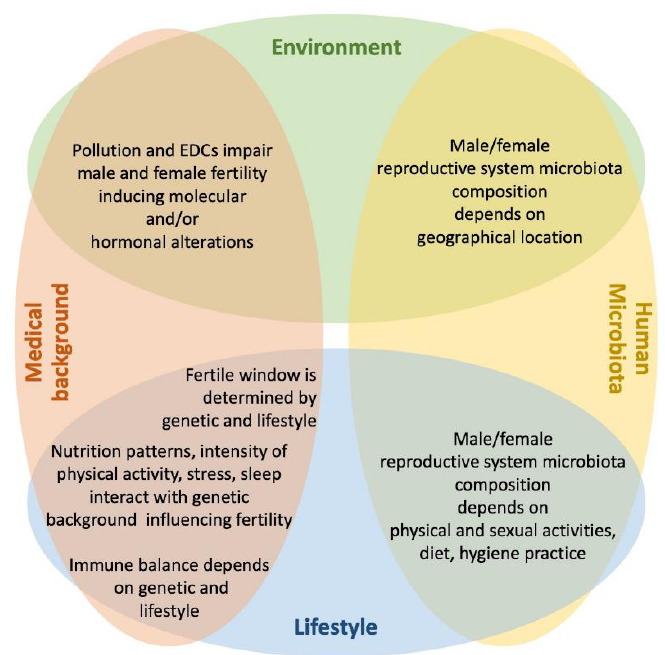
Figure 5. Intrinsic (microbiota and medical background) and extrinsic (lifestyle and environment) factors can have an impact on the overall state of reproductive health. It is interesting to note how what we can choose (i.e., physical activity, diet, habits) intrinsically affect our microbiota and can also modify what we have inherited (i.e., medical or genetic background). Moreover, even what we are exposed to (i.e., pollution and EDCs) modifies the microbiota composition and impacts the medical and genetic background (i.e., fertile window).